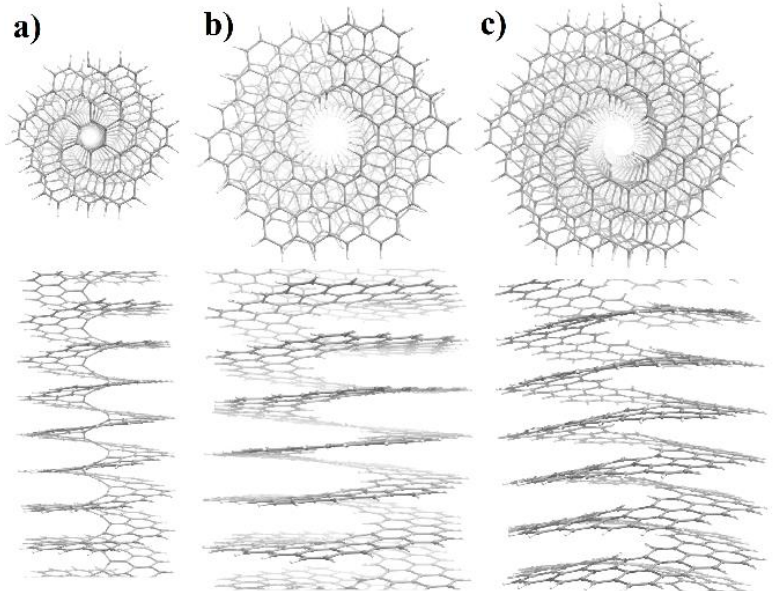
Figure 3. Top and side views of the atomic structures of NHs corresponding to the energy minima. ( a ) [1.2] NH af ; E rel (123.086°) = − 7.523 kJ/mol. ( b ) [2.2] NH af , global minima; E rel (115.617°) = − 10.225 kJ/mol. ( c ) [2.2] NH af , local minima; E rel (122.579°) = − 9.284 kJ/mol.